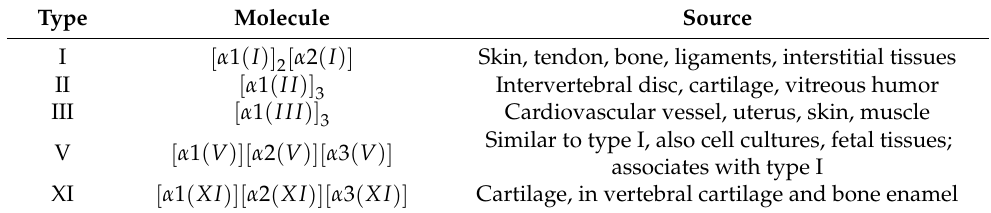
Table 2. Collagen types, compositions and sources (based on